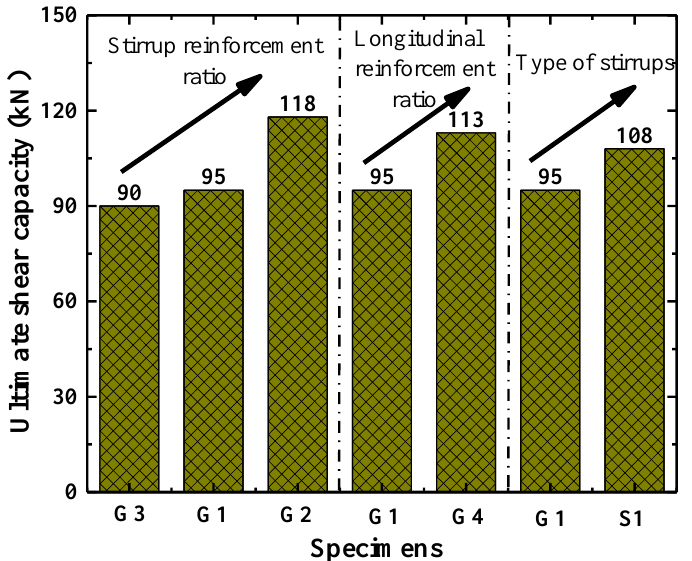
Figure 13. Shear capacity comparisons.